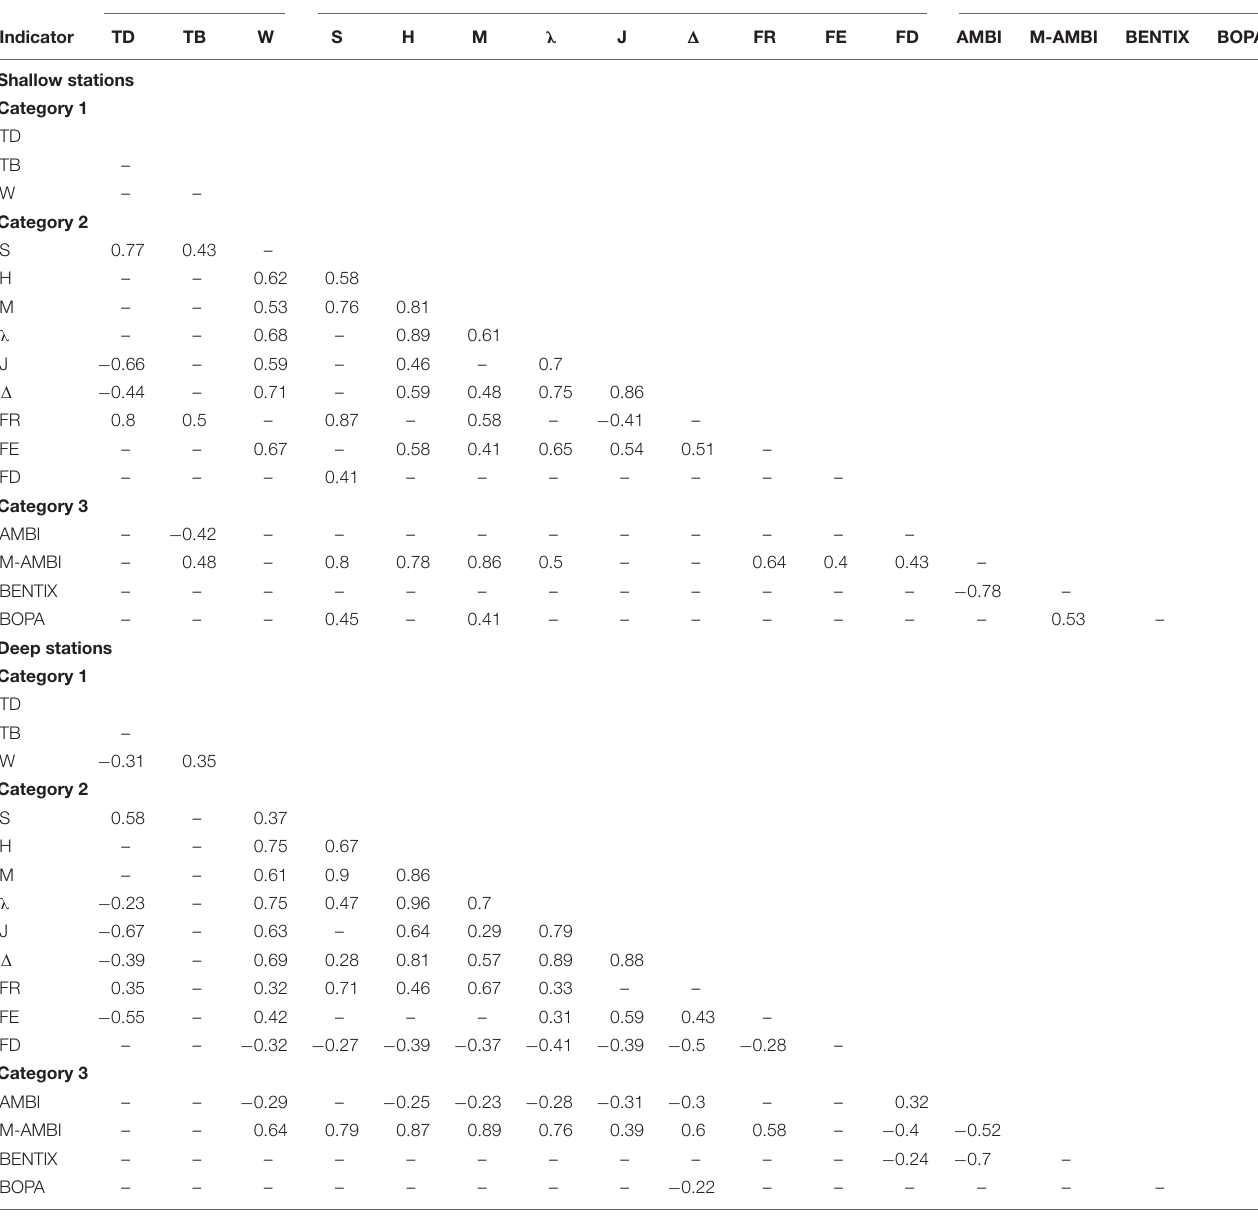
TABLE 4 | Spearman rank correlation coefficients between indicators, for shallow and deep stations. Category